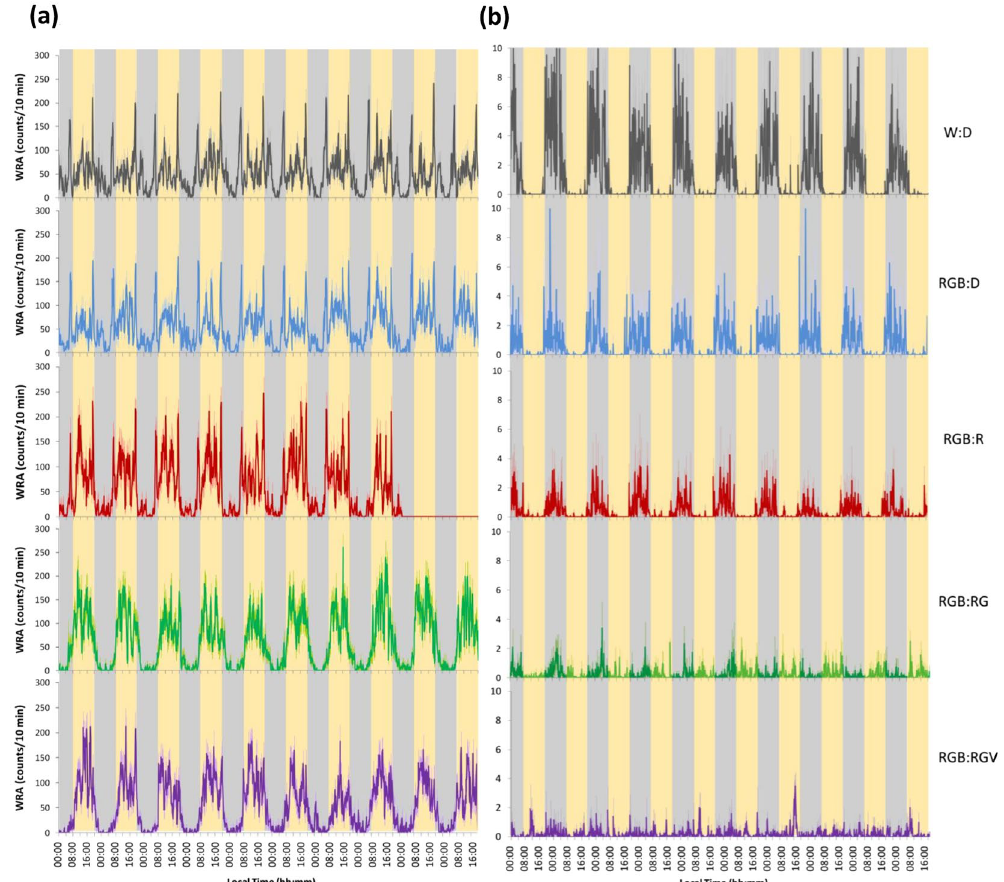
Figure 2. Average wheel running activity (WRA). Ten-day average WRA under the different light cycles in degus (3A, n = 27) and rats (3B, n = 12): W:D (grey line), RGB:D (blue line), RGB:R (red line), RGB:RG (green line) and RGB:RGV (purple line) (for more details, see the Materials and Methods section). Pale lines represent SEM. Grey and yellow columns indicate nocturnal and diurnal periods, respectively. For details on lighting conditions, see Fig. 9 legend. Two days from the RGB:R period are missing due to an error in the data acquisition system. Please note that the WRA scale for rats is not the same than that for